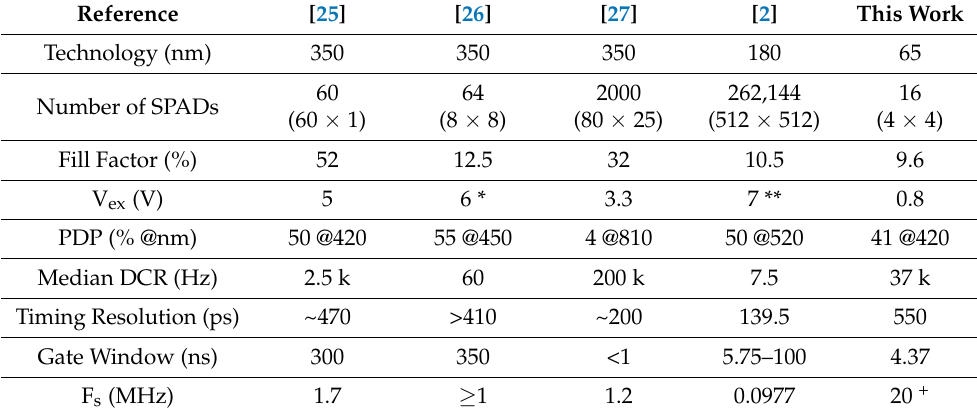
Table 1. Performance comparison of time-gated